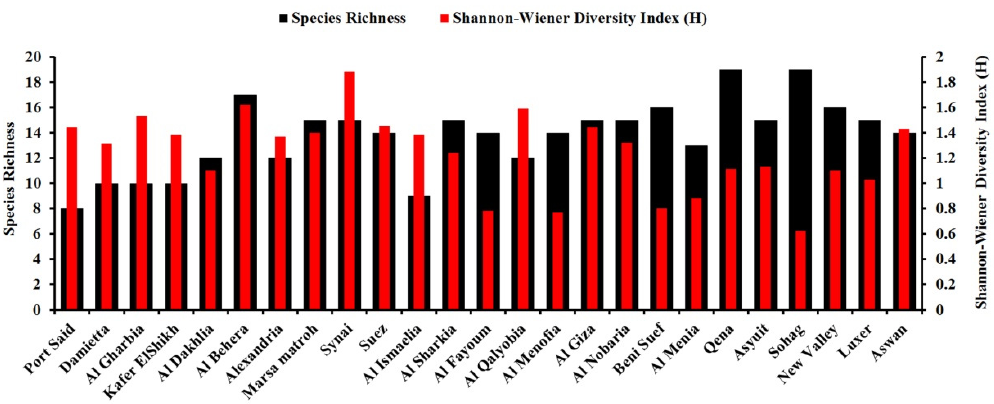
Figure 3. Species diversity (the Shannon–Wiener diversity index) and species richness (total number of fungus species identified) of the seed-borne fungus species identified in grain samples from each of the 25 wheat-growing governorates in Egypt.